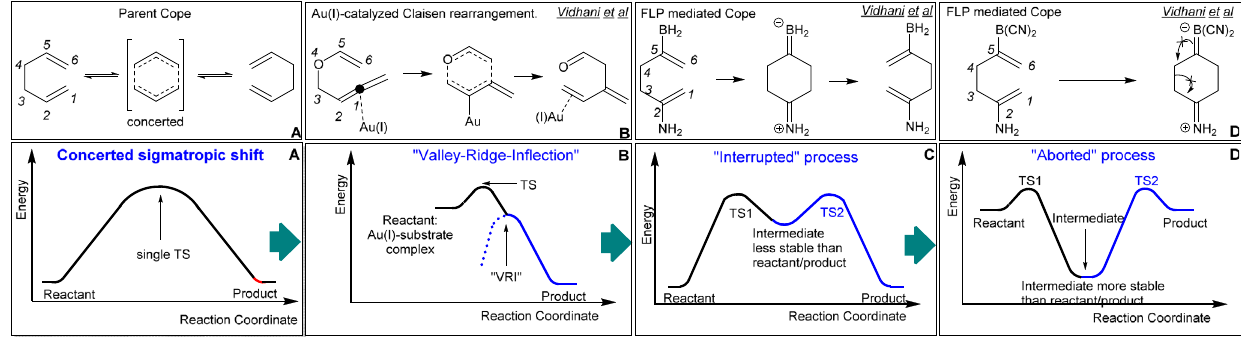
Fig. 3 Evolution of concerted potential energy surface (PES) into interrupted and aborted pathways. A Parent Cope rearrangement, B Au(I)-catalyzed Claisen rearrangement displaying in fl ection along the PES, C FLP-mediated interrupted Cope rearrangement, and D FLP-mediated aborted Cope